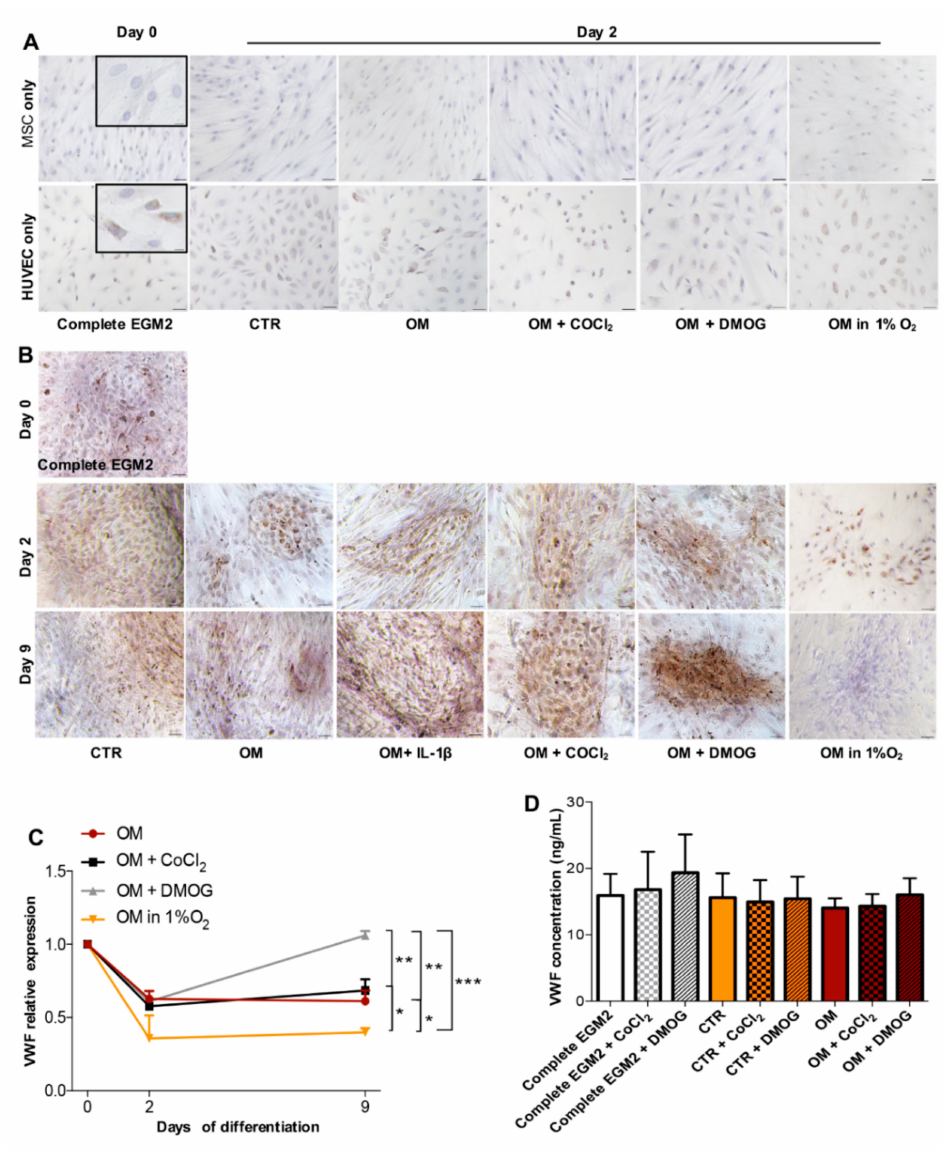
Figure 3. Expression of endothelial cell marker—VWF. ( A ) IHC analysis of VWF expressed by BMSC and HUVEC in monoculture at day 0 in medium Complete EGM2 and at day 2 in media CTR, OM, OM supplemented with COCl 2 or DMOG and OM in 1% O 2, scale bar 50 µ m, inset scale bar 25 µ m. ( B ) IHC analysis of VWF expression by cocultured cells in di ff erent conditions at day 2 and day 9, scale bar 50 µ m. ( C ) Relative gene expression of VWF shown by qPCR (n = 3, ∗ p ≤ 0.0228, ∗∗ p ≤ 0.0057, ∗∗∗ p = 0.0006). ( D ) Quantification of VWF released to the medium performed by the ELISA method. The cells were incubated in media Complete EGM2, CTR and OM in the presence / absence of COCl 2 or DMOG for 24 h followed by another 24 h in the medium containing 0.1% FBS only (n = 3, p >